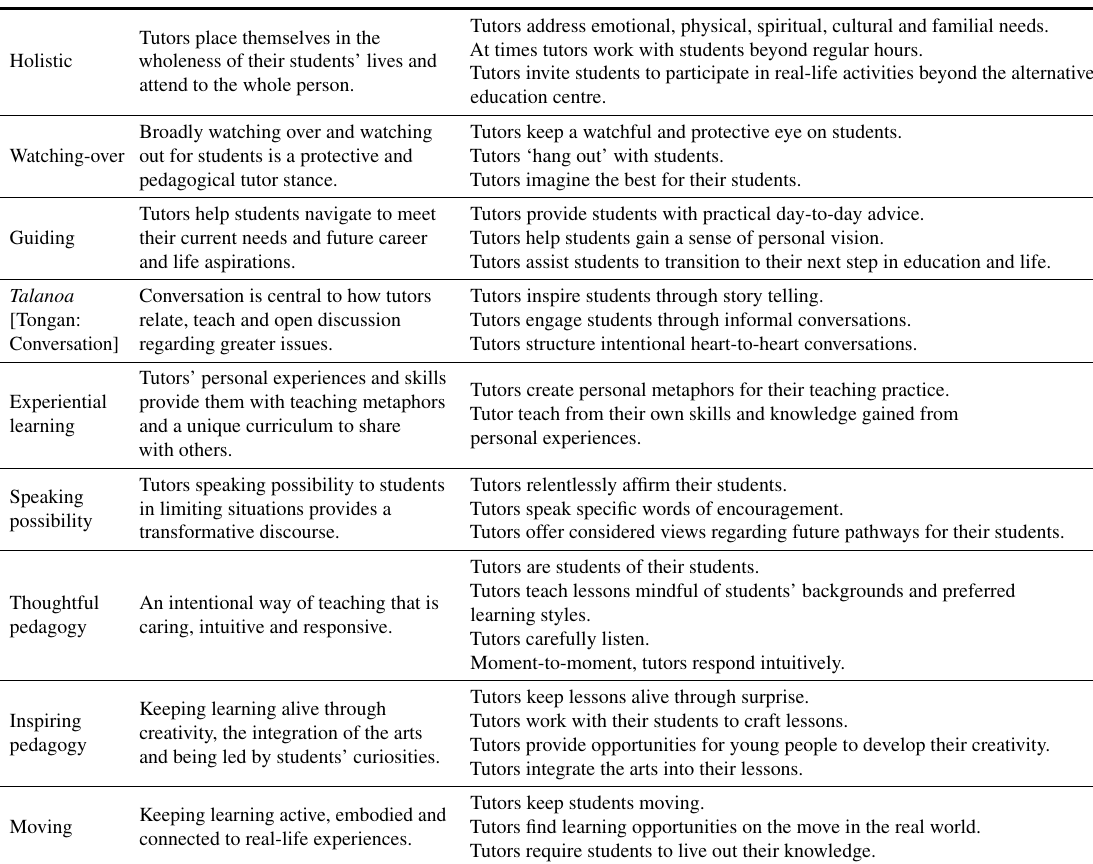
Table 3. Tutor pedagogy (Schoone, 2016, pp. 129–130).